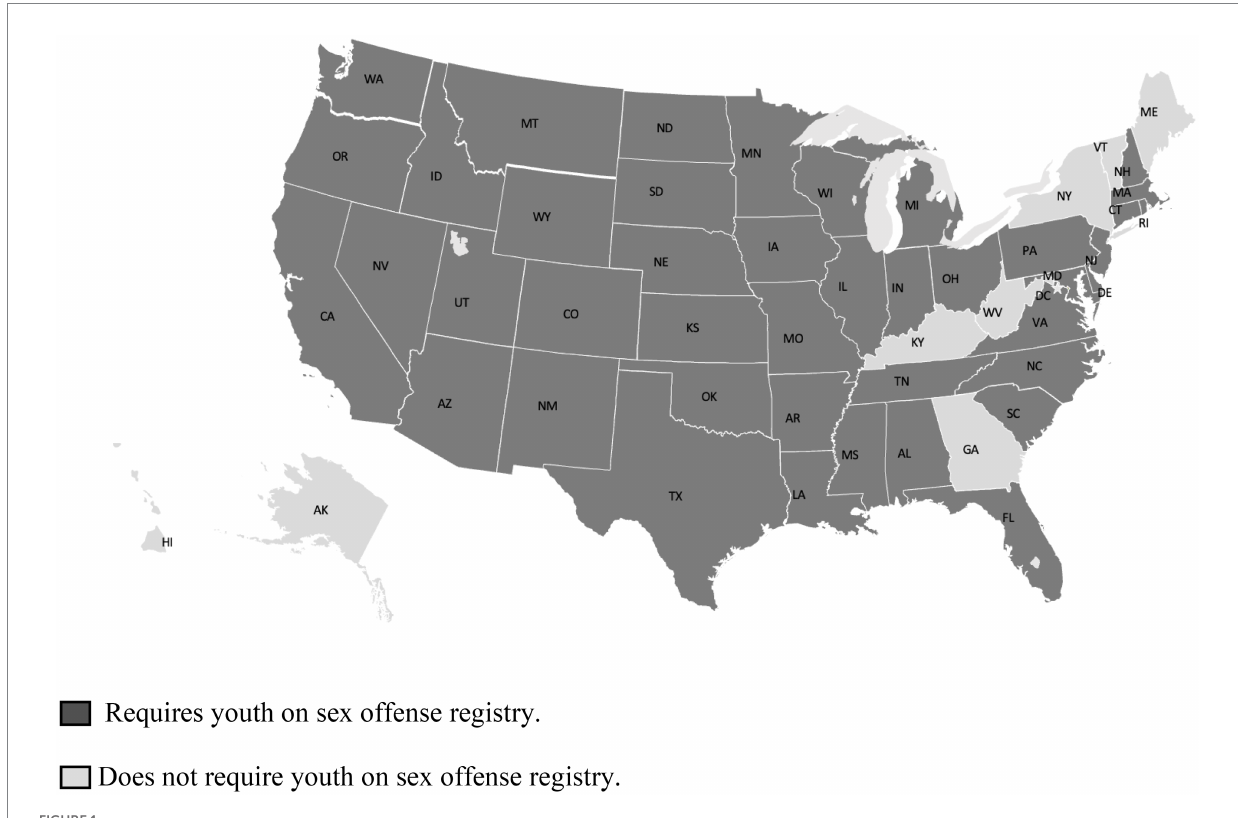
FIGURE 1 States requiring youth to be placed on sex offense registries ( N =